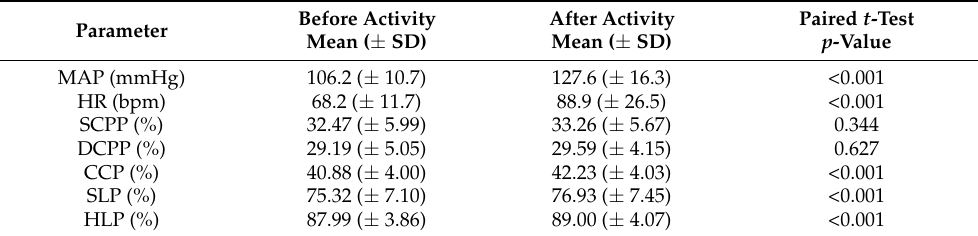
Table 3. Functional parameters before and after dynamic activity.